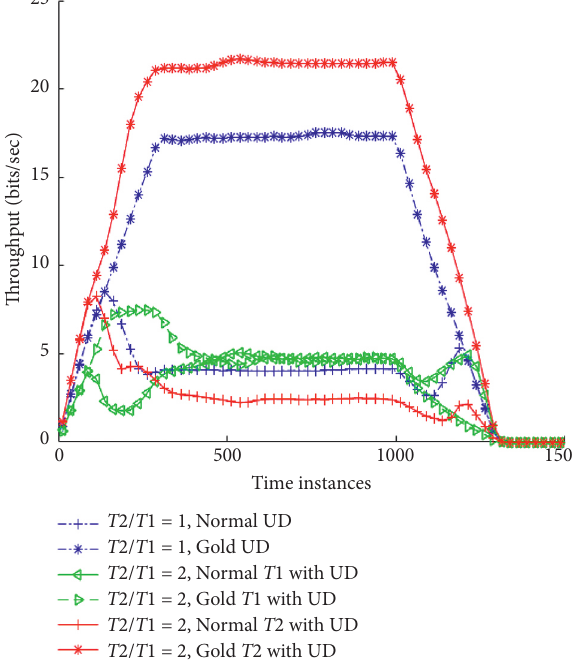
Figure 7: Mean load history of all users with 50% gold users.